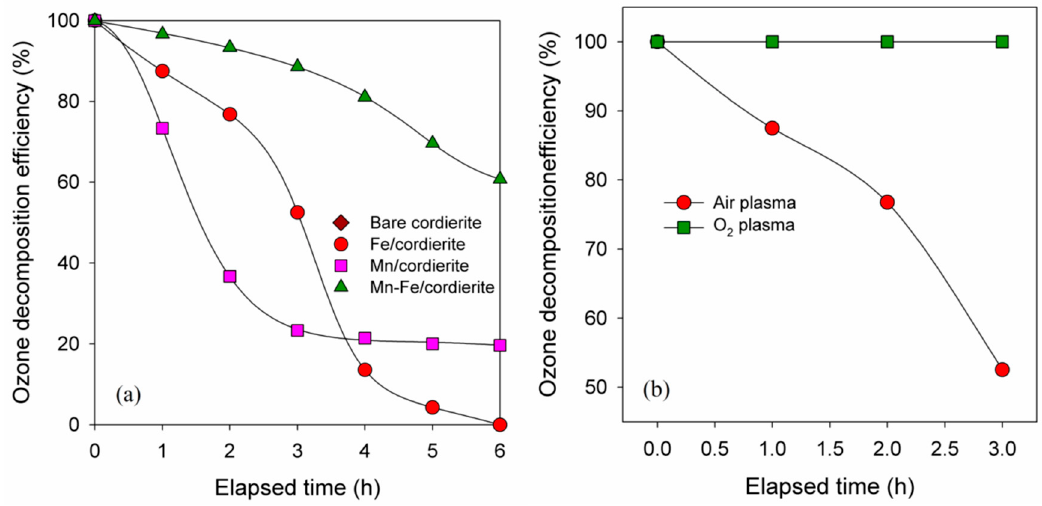
Figure 2. ( a ) Ozone decomposition efficiency of prepared catalysts with air plasma (initial ozone concentration: 300 ppm); ( b ) Ozone decomposition efficiency of Fe/cordierite with oxygen plasma (initial ozone concentration: 300